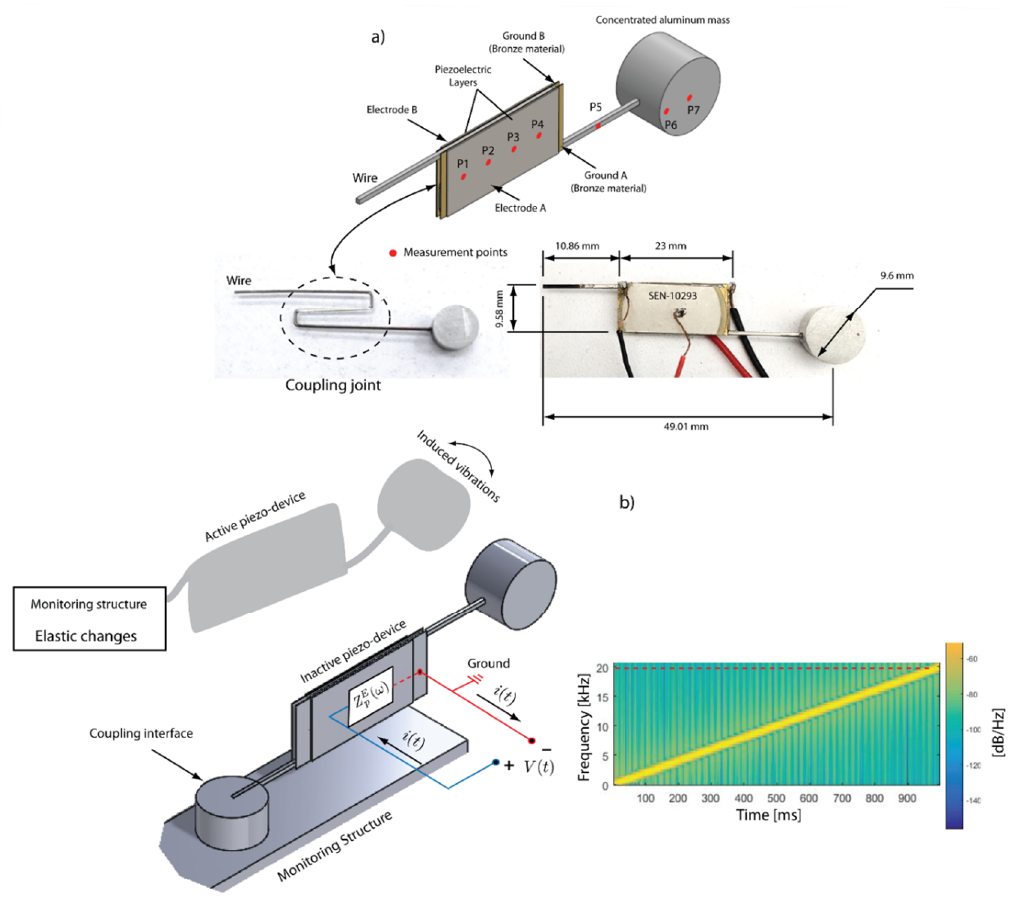
Figure 2. ( a ) Piezo-device design, dimensions and measurement points. ( b ) Piezo-device working principle.